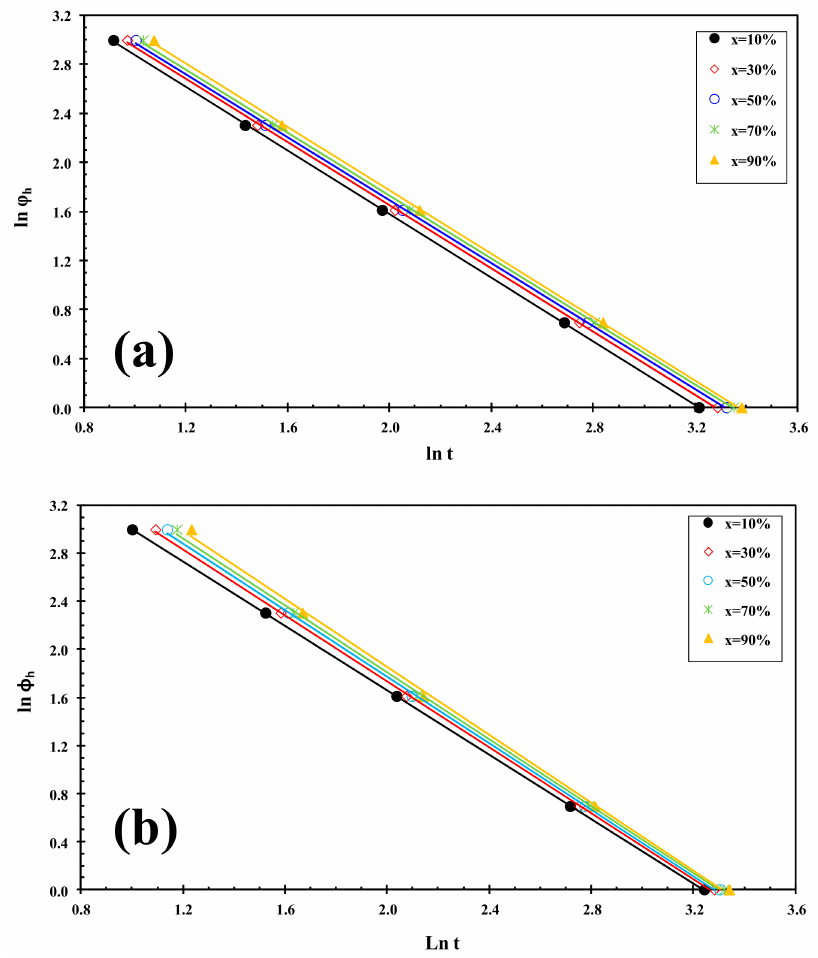
Figure 6. Liu plots for cold-crystallization of ( a ) PLLA and ( b ) PLLA/2D-WS 2 (0.5